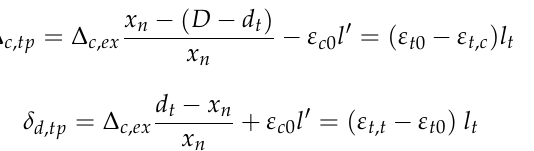
Figure 6. Force equilibrium condition at beam end.